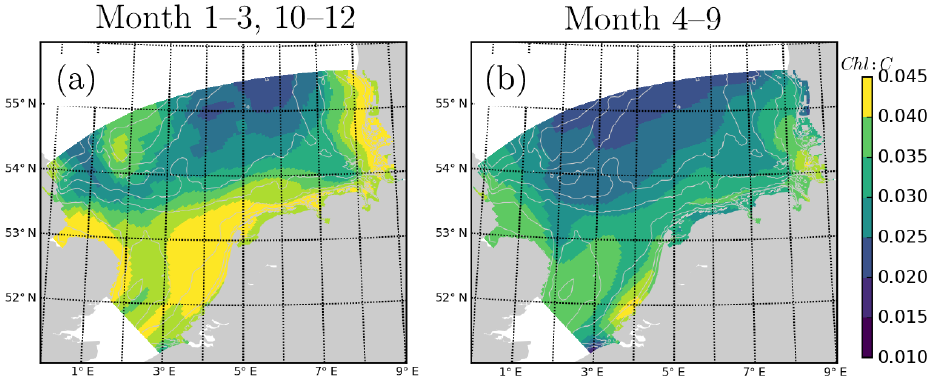
Figure 13. Chlorophyll:C ratio in phytoplankton, averaged over the non-growing (a) and growing season (b) of 2010. Gray lines in (a) – (d) show the isobaths.